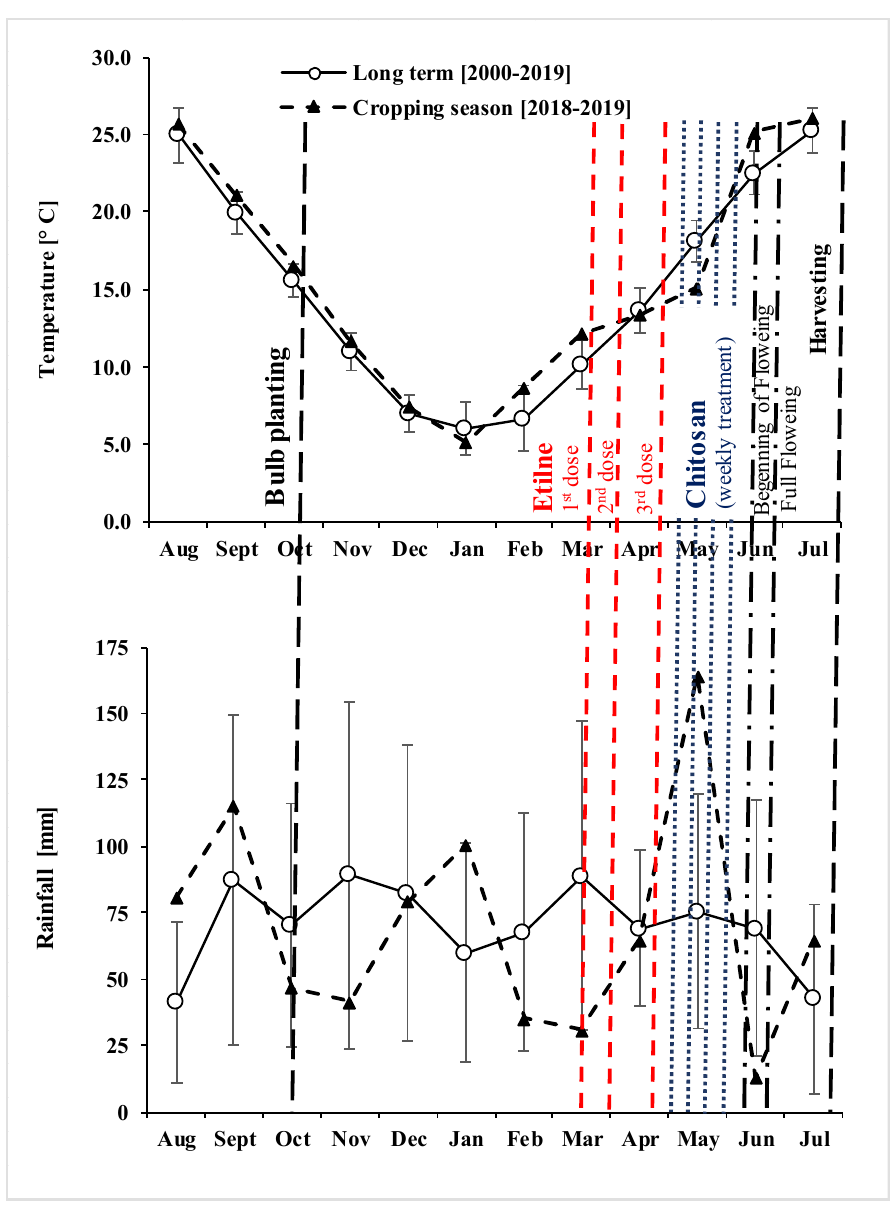
Figure 1. Long term (2000–2019) and cropping monthly season temperatures close to the experimental site. The figures report the dates of the onion bulb planting and infructescence harvesting (black long-dashed lines), the dates of the 3 moments of Ethylene application (red short-dashed lines), the dated of the chitosan application (blue dotted lines) and the dates of the beginning and full flowering (black dash-dotted lines). Moment of ethylene application included an early, mid, and late applications indicated as first, second and third (1st, 2nd, and 3rd, respectively) occasions in the figures. Amount of ethylene application included 100% recommended rate (in the 1st or 3rd occasions) or 100% in the 1st + 50% in either the 2nd or 3rd occasions. Chitosan application was performed in “Treat”